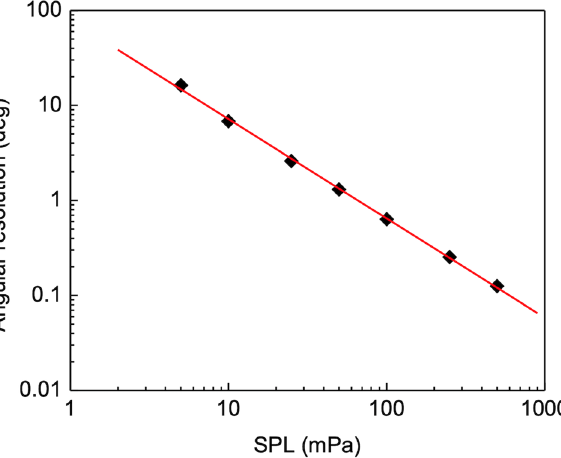
Figure 13. Angular resolution versus SPL. The minimum detectable angle step (angular resolution) is determined from the associated phase shift standard deviation for every SPL applied to the sensor. The linear relationship between phase shift and angle of arrival (Fig. 11) enables the determination of angular orientation uncertainty. A unitary SNR translates into the minimum detectable signal being equal to that uncertainty for each SPL the sensor is